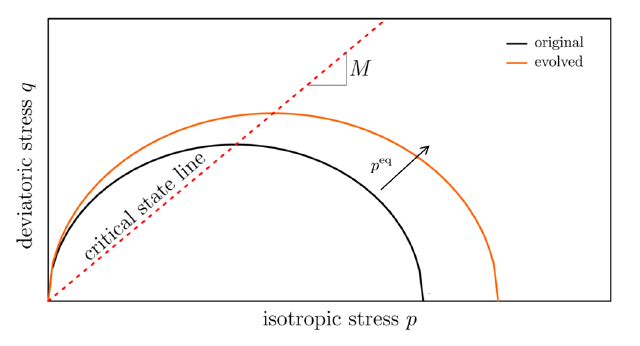
Figure 1. Original and evolved domain for the plastic potential p eq in the deviatoric-hydrostatic plane.